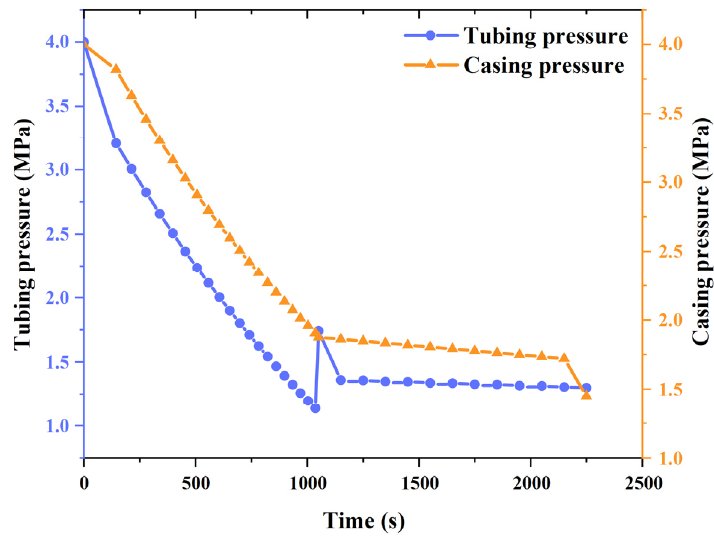
Figure 5. Variation in tubing and casing pressure during the upward and renewal phases.